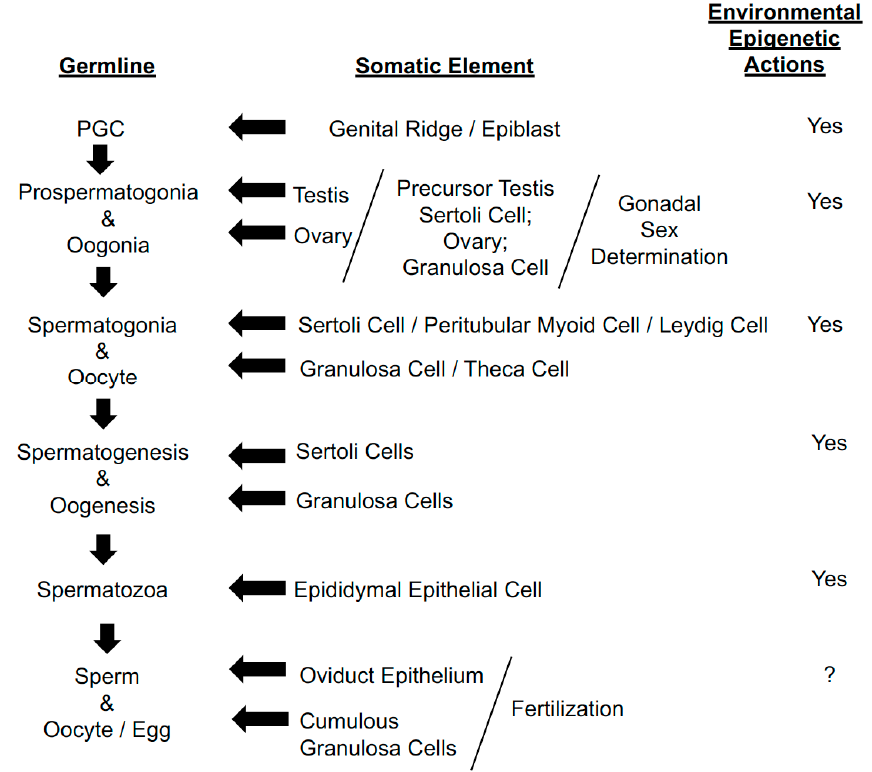
Figure 1. Somatic cell impacts on germ cells. Various germ cell stages from primordial germ cells (PGC) to sperm and egg and the somatic cells that regulate and impact the development and molecular differentiation. The sites of environmental epigenetic regulation are indicated.